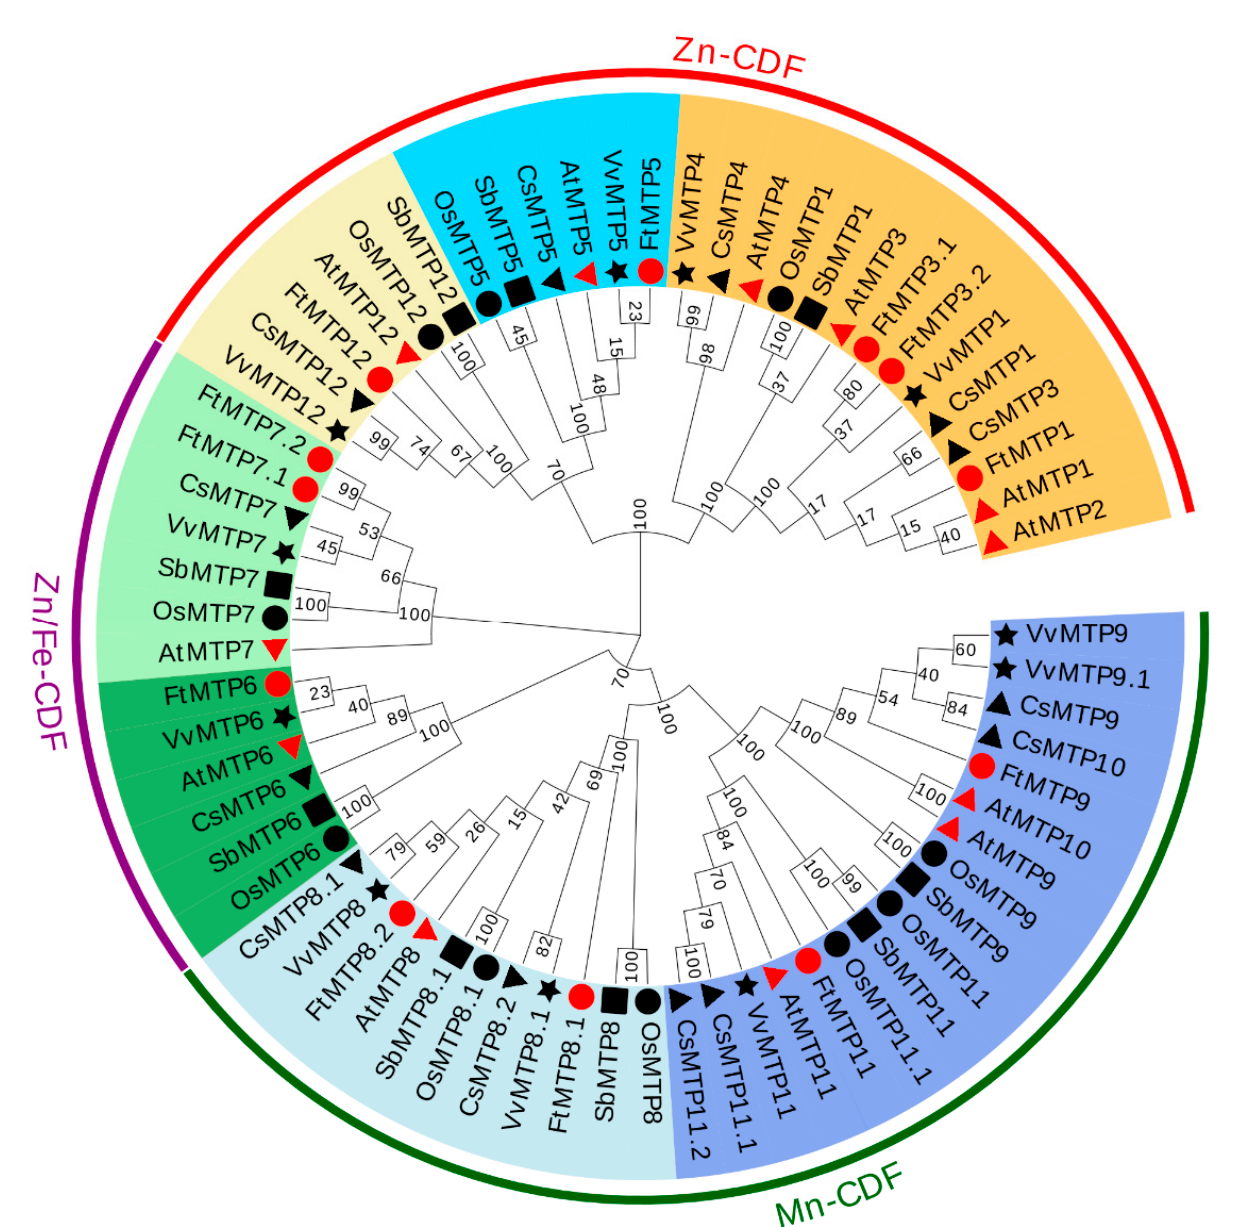
Figure 1. A phylogenetic tree based on 67 MTP proteins: 12 Arabidopsis (marked by red triangle), 10 rice (black circle), 11 grape (black star), 9 sorghum (black square), 13 tea plant (black triangle), and 12 Tartary buckwheat (red circle). The phylogenetic tree was constructed using the neighbor-joining (NJ) method and MEGA 7.0 software at 1000 replications bootstrap. The diagrams were compiled, labeled, color-coded, and visualized using EvolView v3.